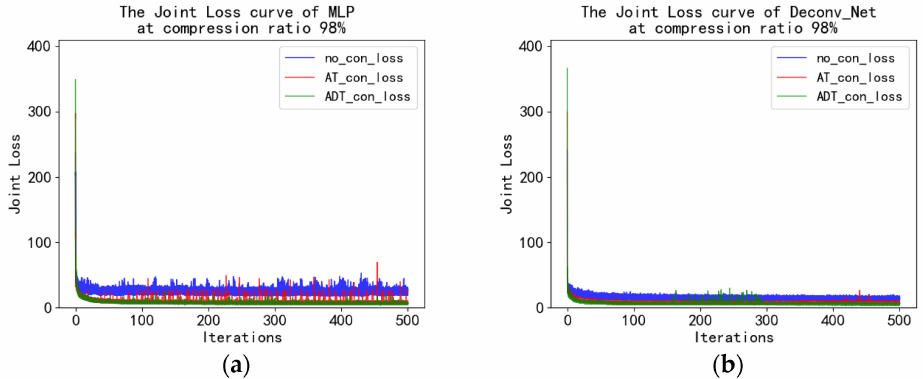
Figure 16. The joint loss curve with the end-to-end MLP model ( a ) and the end-to-end Deconv_Net model ( b ) at a compression ratio of